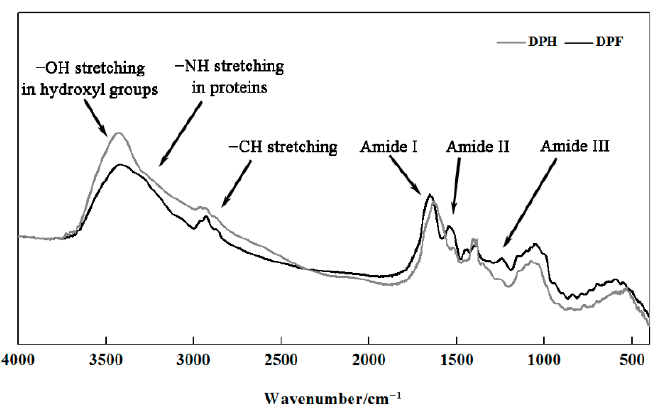
Figure 4. Fourier transform infrared (FT-IR) spectra of DPF and DPH.